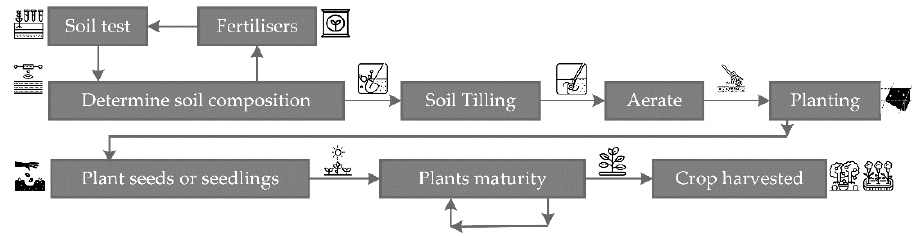
Figure 3. Conventional steps in agronomy.